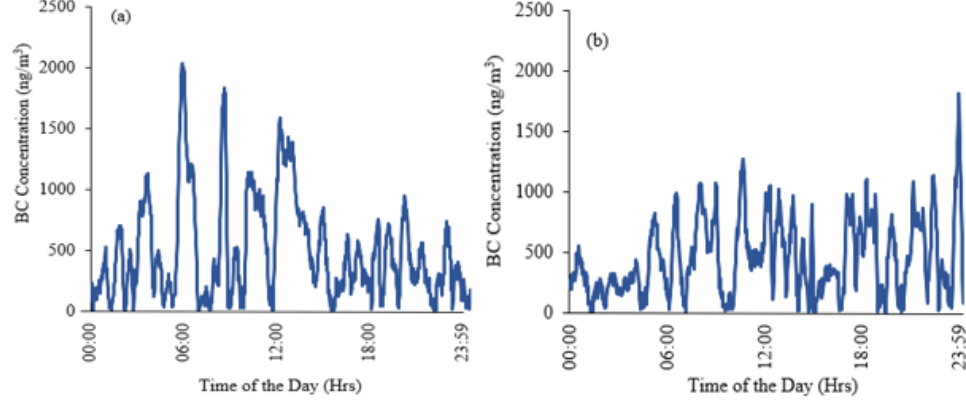
Figure 8. Black carbon variability at the Port of Albany during 16-17 November 2018 ( a ) weekday and ( b ) weekend: Friday and Saturday).